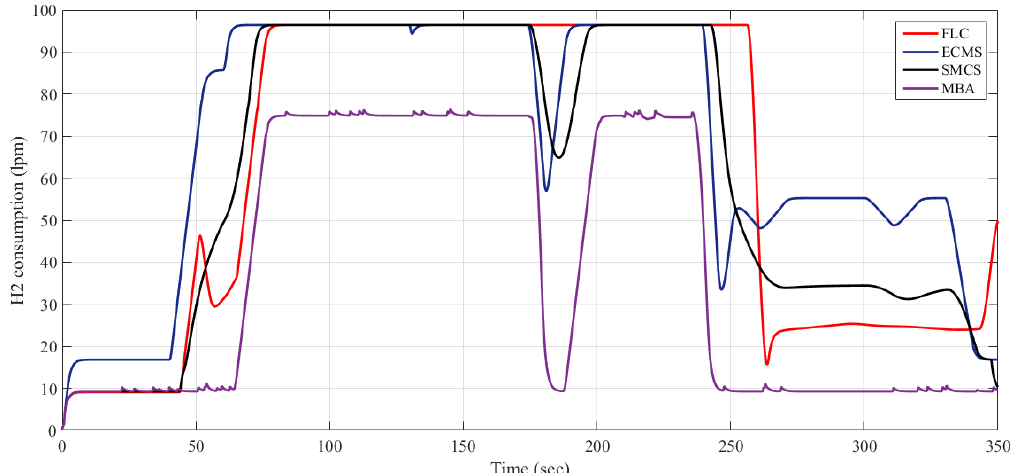
Figure 10. H 2 consumption variation for different considered methods.